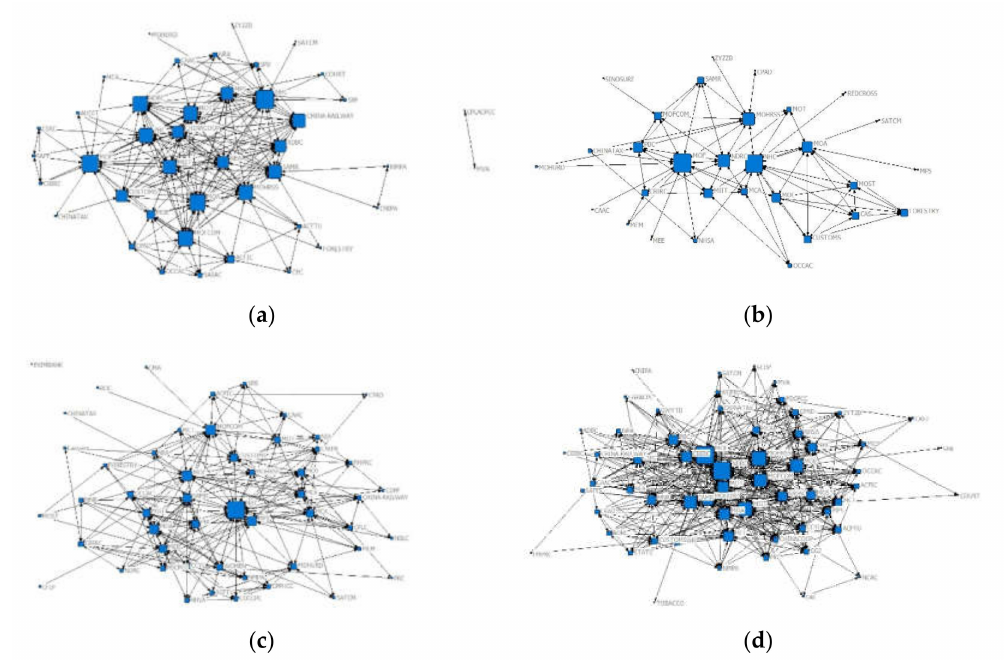
Figure 2. Collaborativedecision-makingnetworksineachphase. ( a )T1(20January2020–20 February